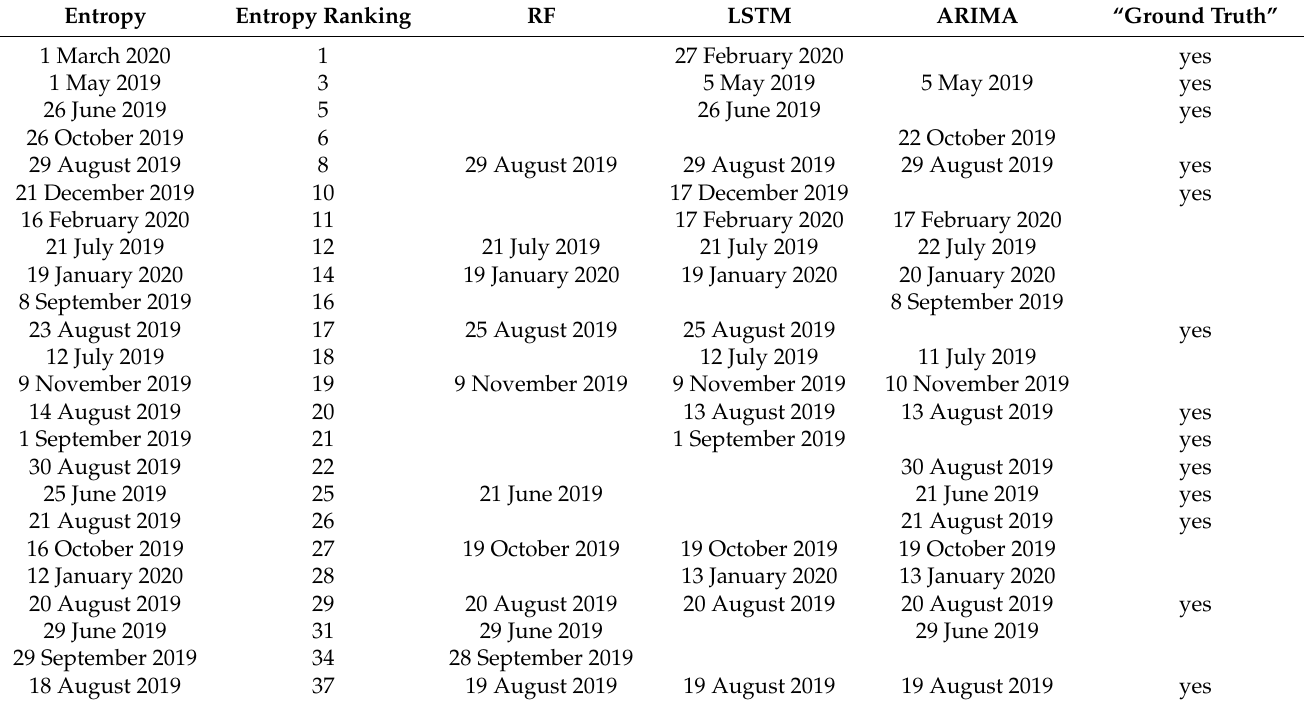
Table 8. Anomalous days of household